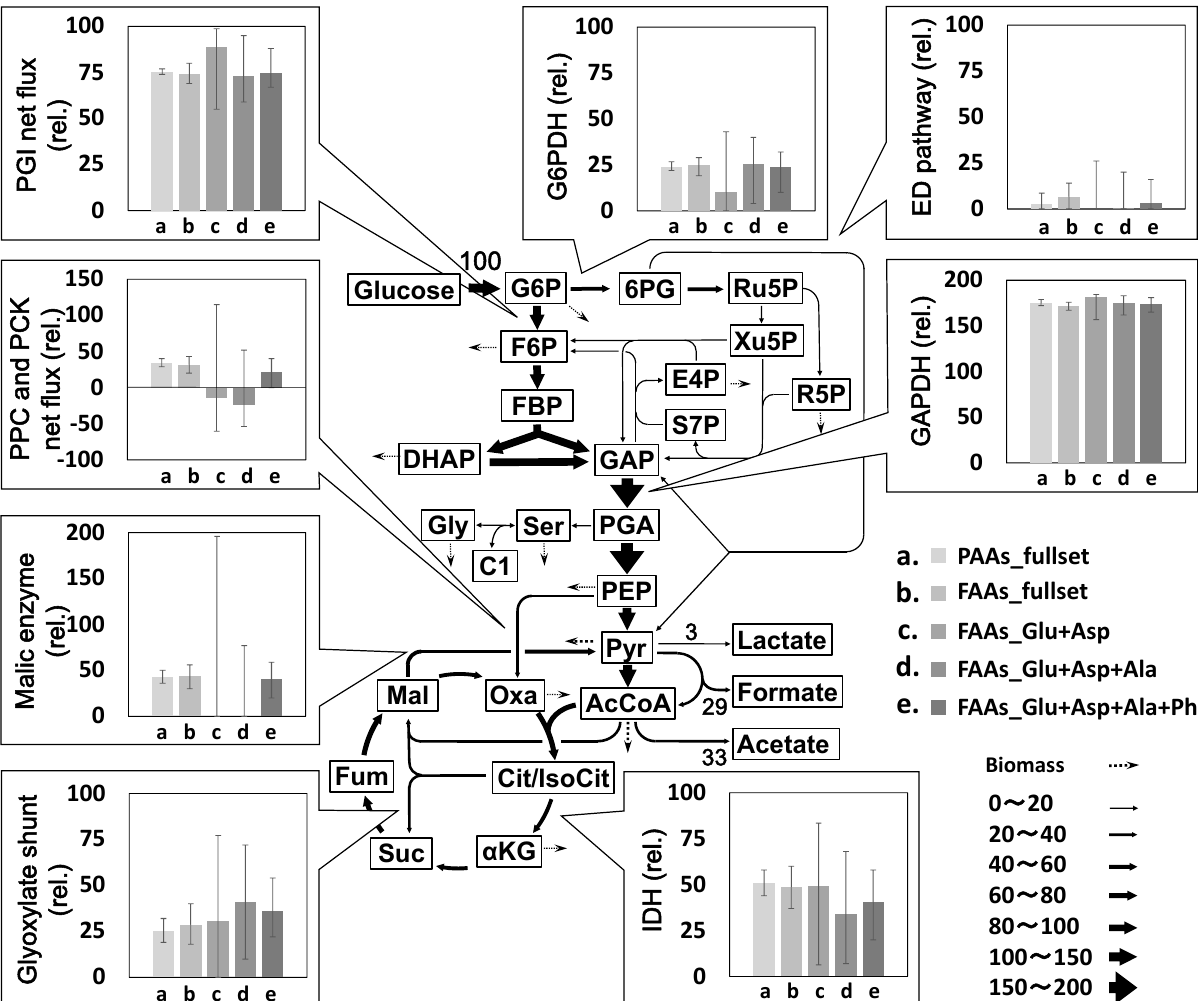
Figure 3. Comparison of metabolic flux distributions estimated using different datasets. Flux values are normalized to a glucose uptake rate of 100. Fluxes and 95% confidence intervals in representative reactions are shown. Full data is available from Tables S1-1, S2-1, S3-1, S4-1 and